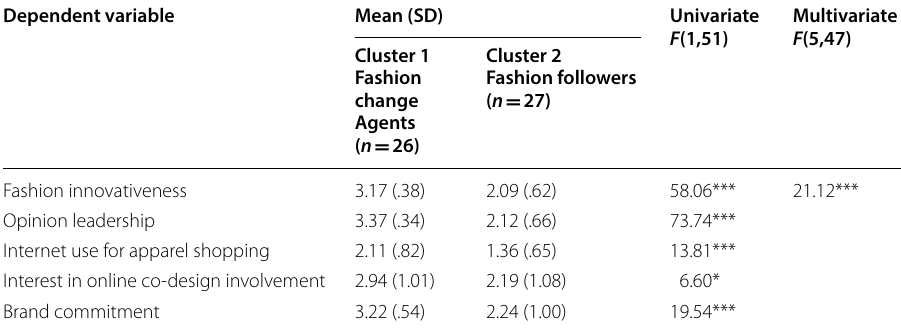
* p < .05; ** p < .01; *** p < .001